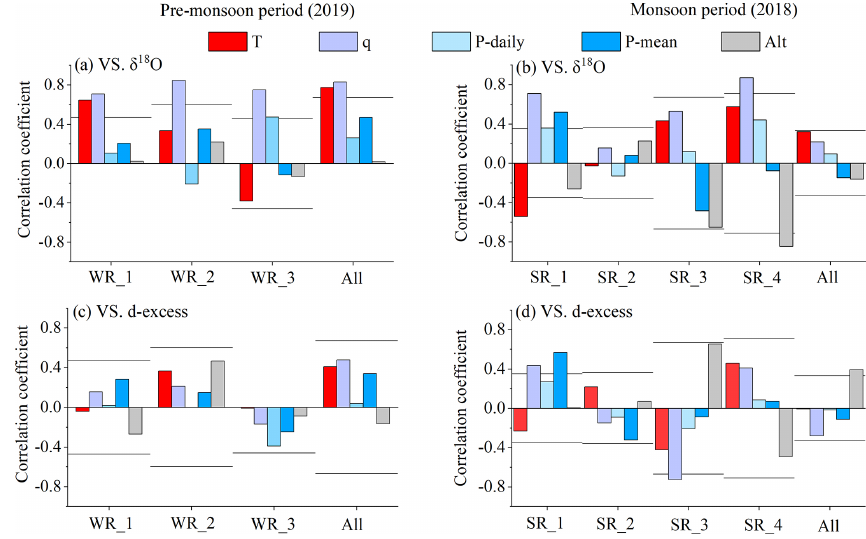
Figure 10. Regional patterns of the correlation between δ 18 O (a, b) , d-excess, (c, d) and various local factors (temperature ( T ), specific humidity ( q ), daily precipitation amount ( P daily), and average precipitation amount over the entire observation period for each observation location ( P mean), and altitude (Alt)). (a, c) is for the pre-monsoon period and (b, d) is for the monsoon period. Horizontal lines indicate the correlation threshold for statistical significance ( p< 0 . 05), considered the degree of